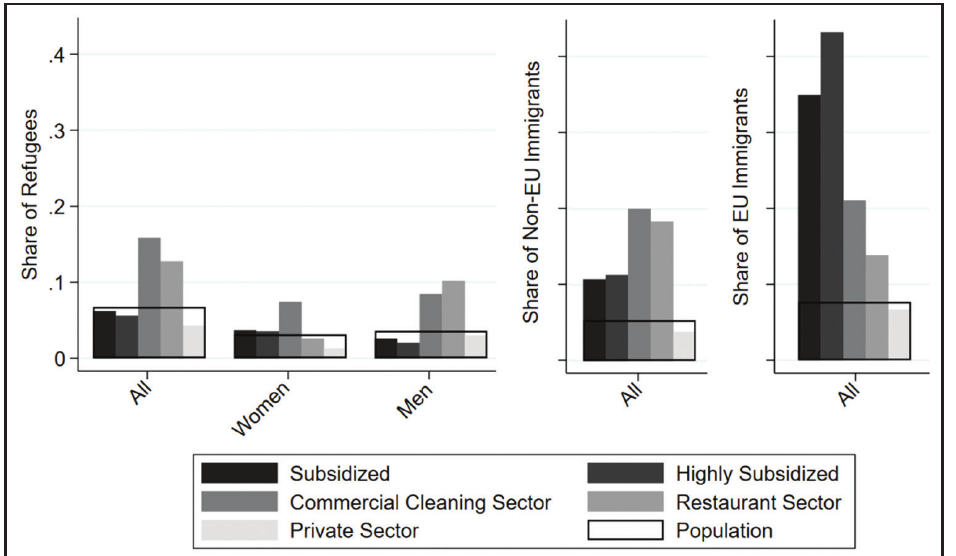
Figure 5 Shares of refugees, EU immigrants and non-EU immigrants across